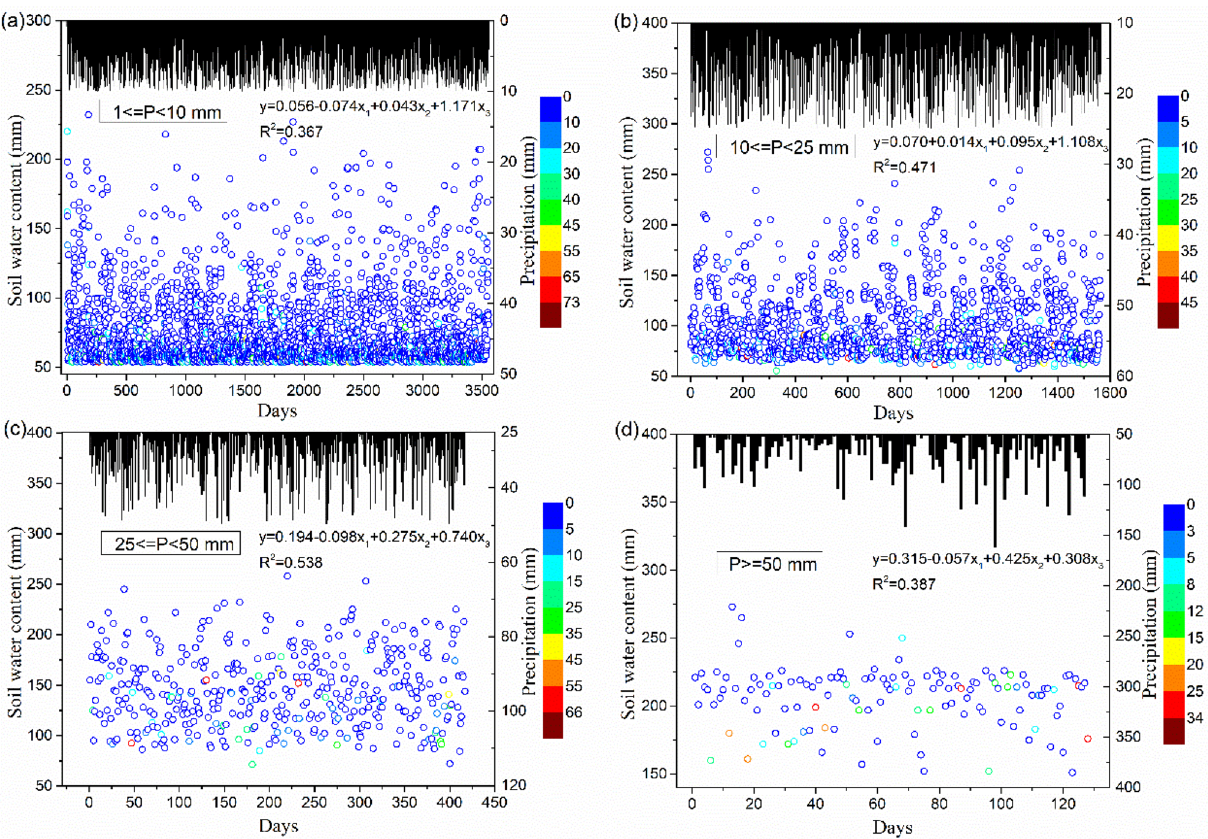
Figure 5. Relationship of soil water content (mm) with current and antecedent precipitation volume (mm) and antecedent dry days at different precipitation amounts: ( a ) light rain (1 ≤ P < 10 mm), ( b ) moderate